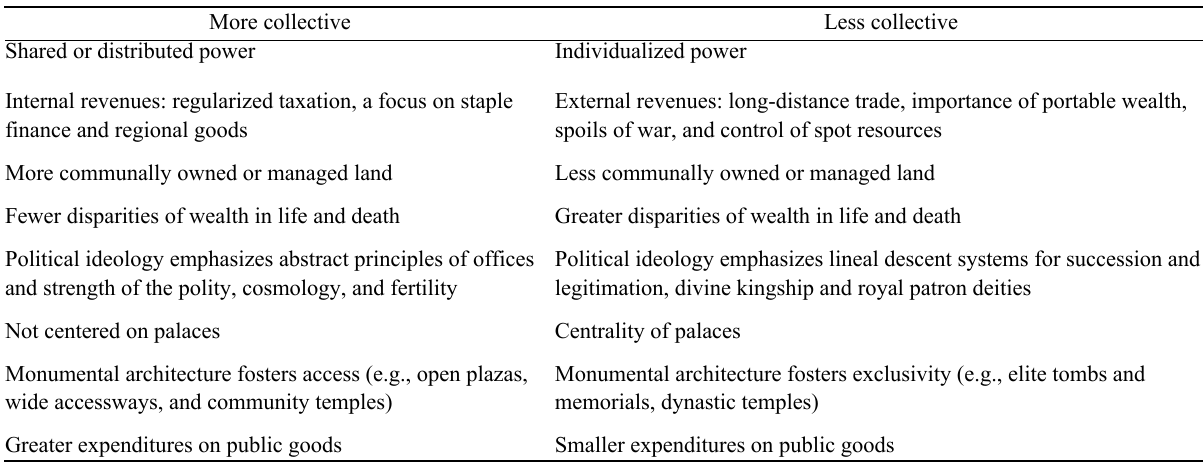
Table 3 Axes of collectivity for premodern complex